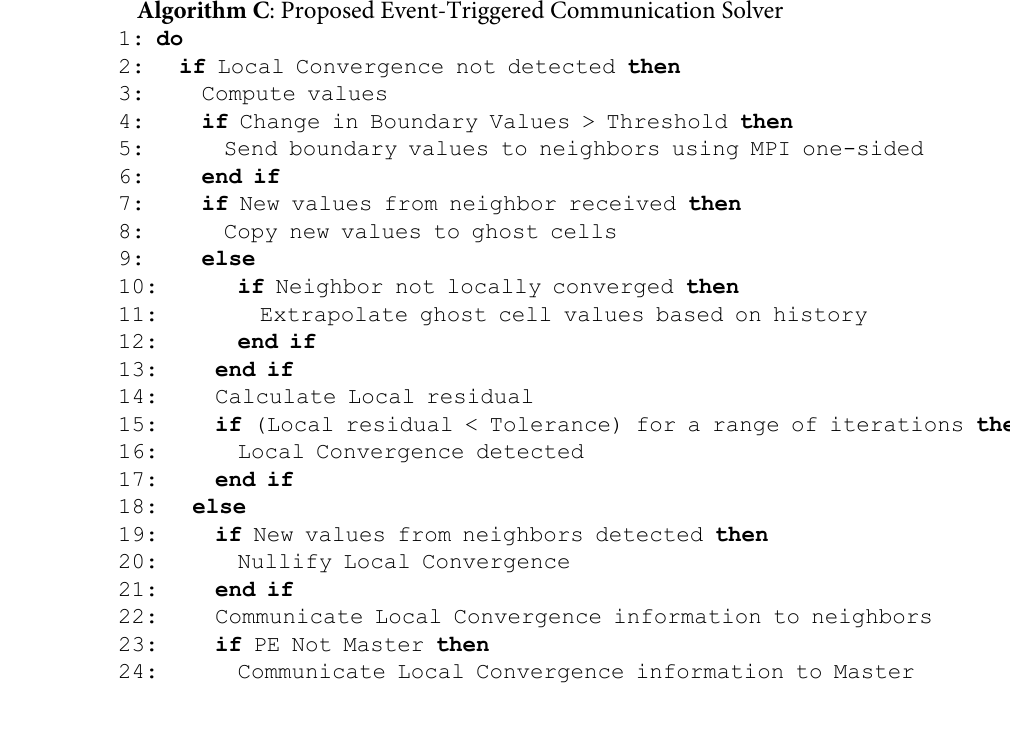
Algorithm C : Proposed Event-Triggered Communication